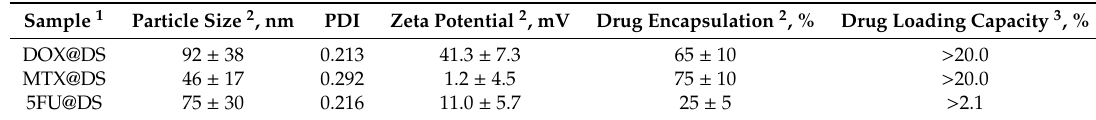
Table 1. Properties of drug-loaded